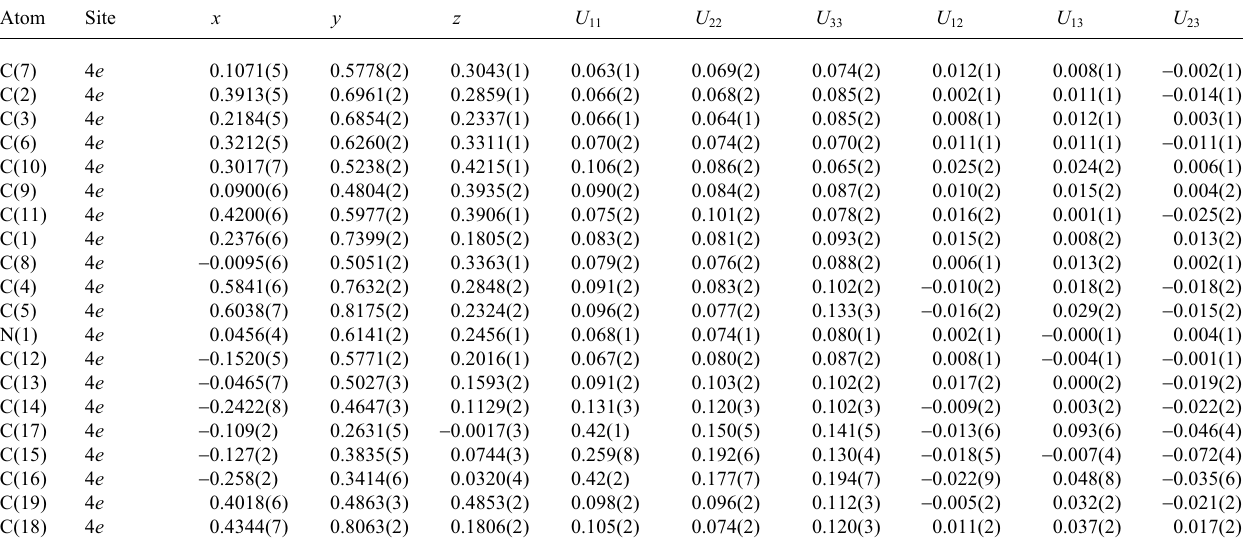
Table 3. Atomic coordinates and displacement parameters (in Å 2 )